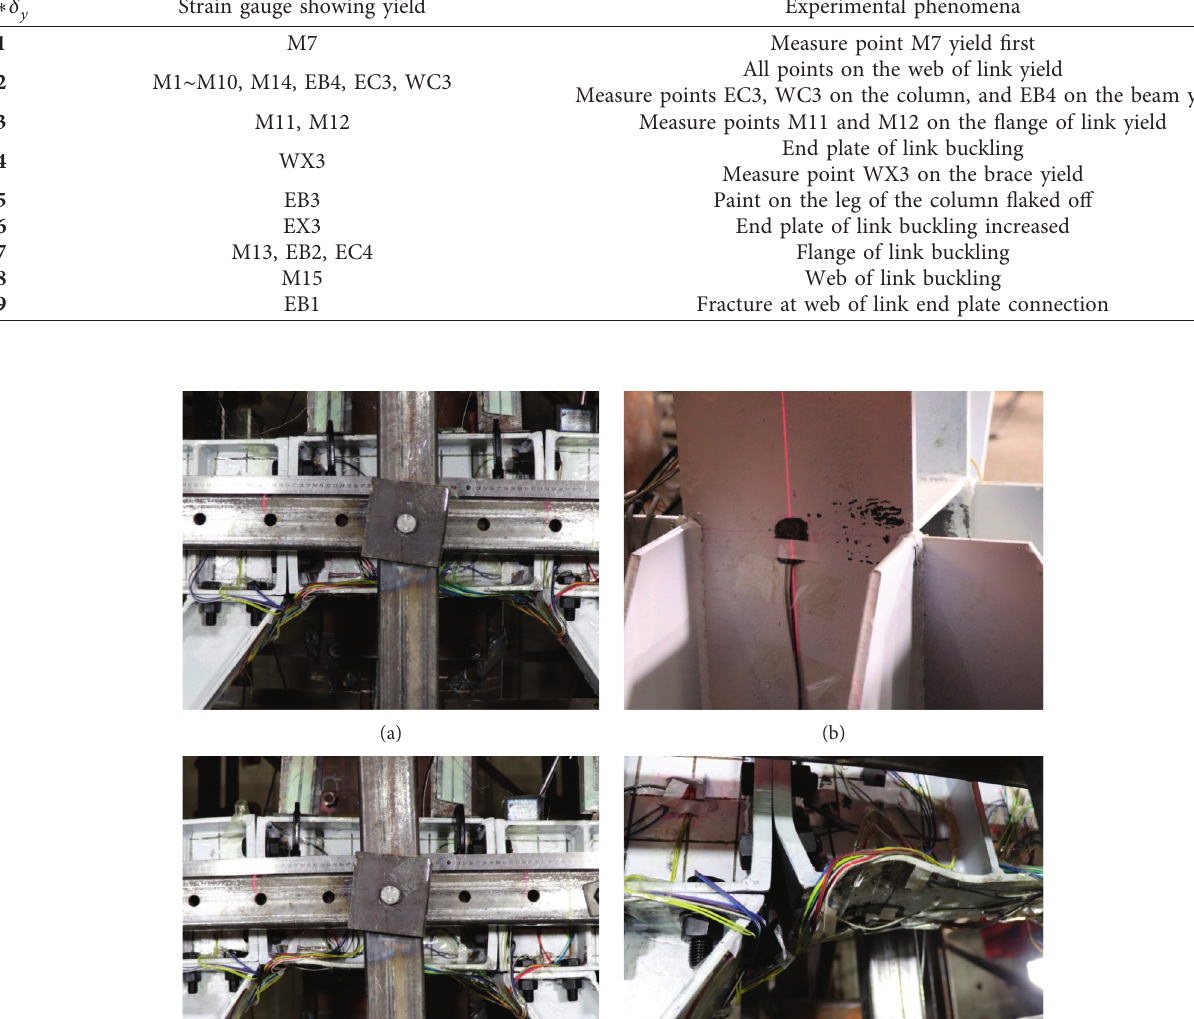
y . (b) Deformation at 5 δ y . (c) Deformation at 7 δ y .